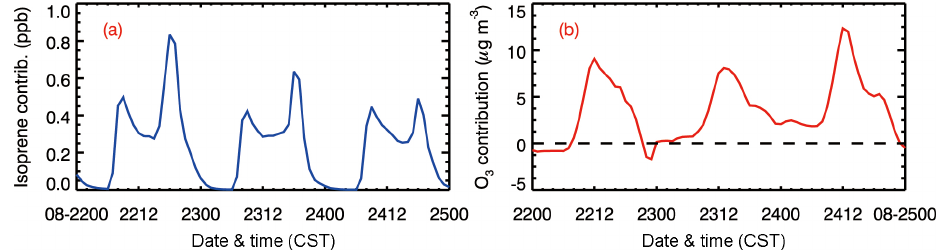
Figure 18. Diurnal variations of contributions of biogenic emissions to near-surface isoprene and O 3 concentrations averaged in Xi’an and surrounding areas from 22 to 24 August 2013.